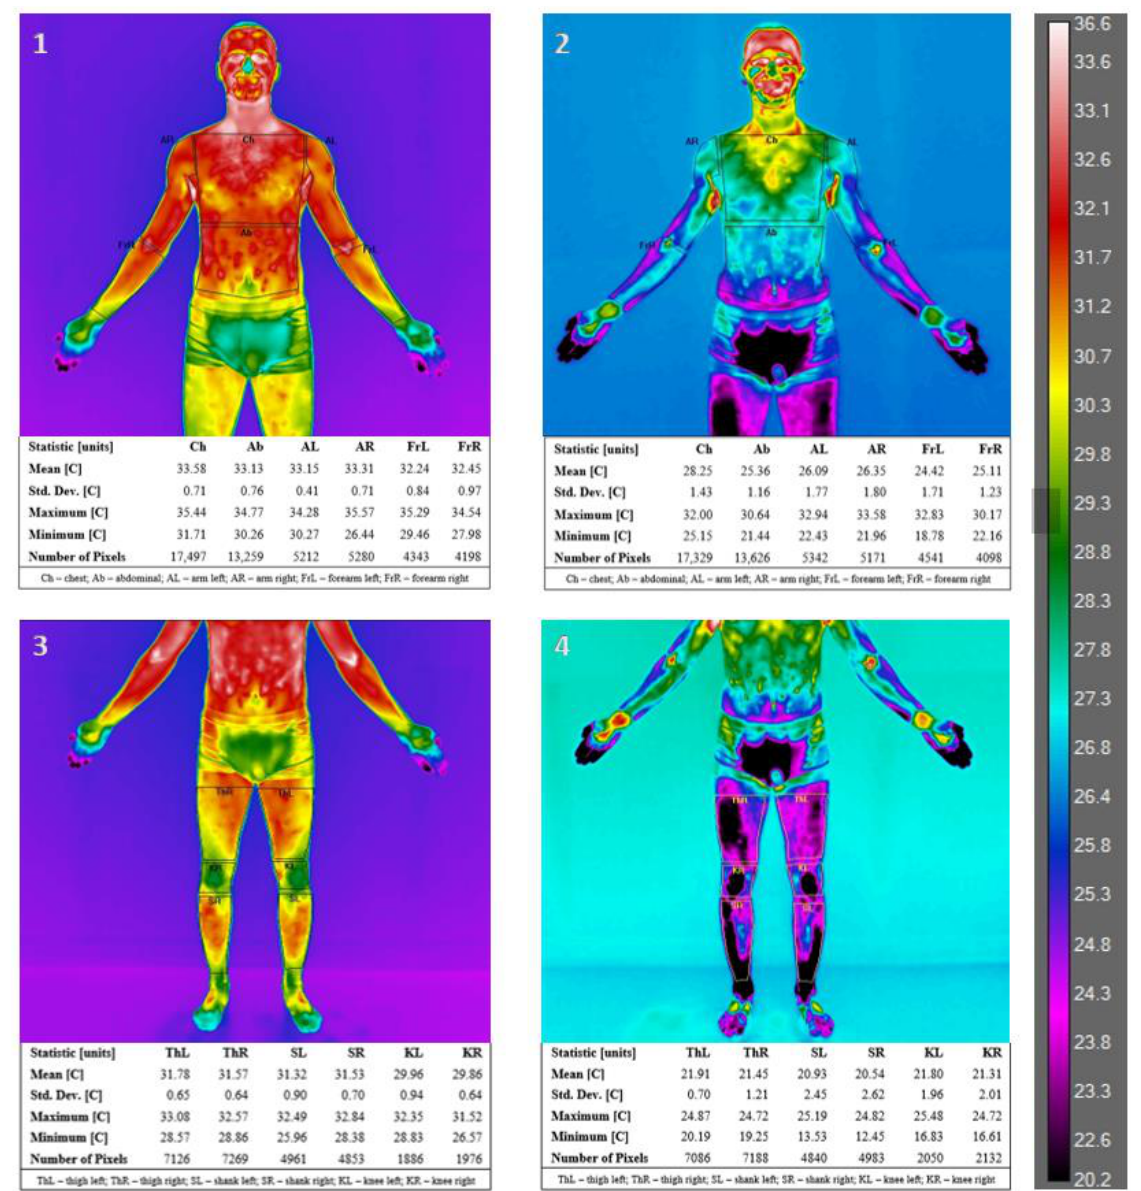
Figure 1. Sample thermographic photos before (1 and 3) and after (2 and 4) partial body cryostimula- tion for the front view. Legend: Ch—chest; Ab—abdominal; AL—left arm; AR—right arm; FrL—left forearm; FrR—right forearm; ThL—left thigh; ThR—right thigh; SL—left shank; SR—right shank; KL—left knee; KR—right knee.